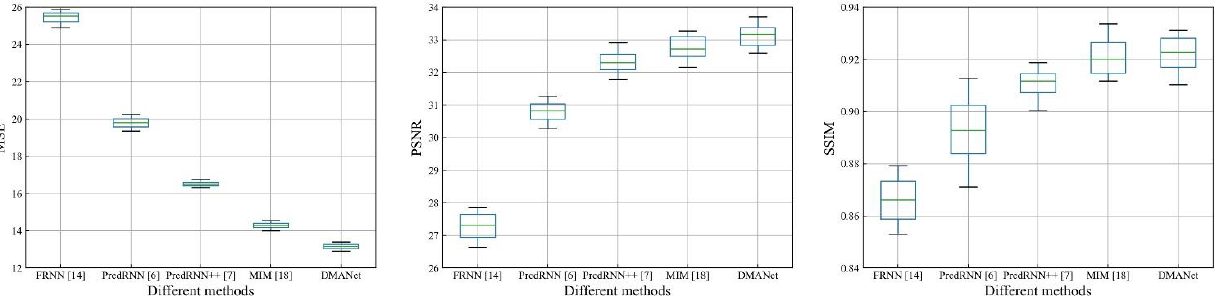
Figure 13. Whisker plot comparisons of the different models at the AR Map.